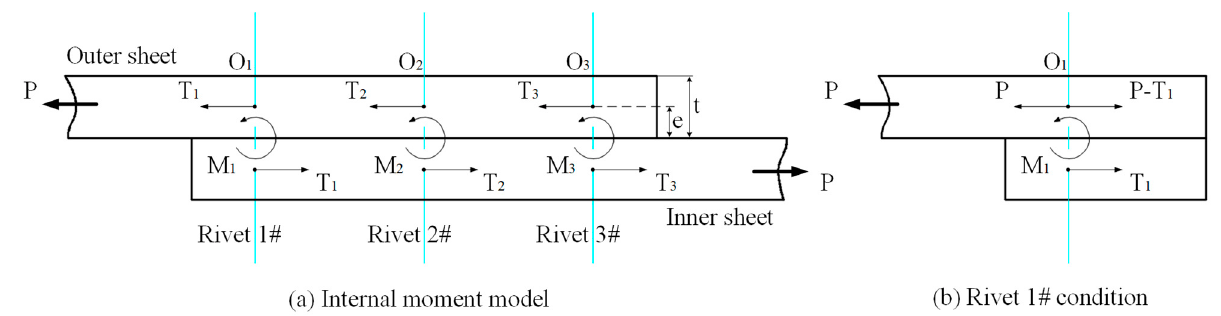
Figure 3. The internal moment model based on the three-row riveted lap joint. ( a ) Internal moment model. ( b ) Rivet 1# condition. Notes: t is the sheet thickness. e is the eccentricity.